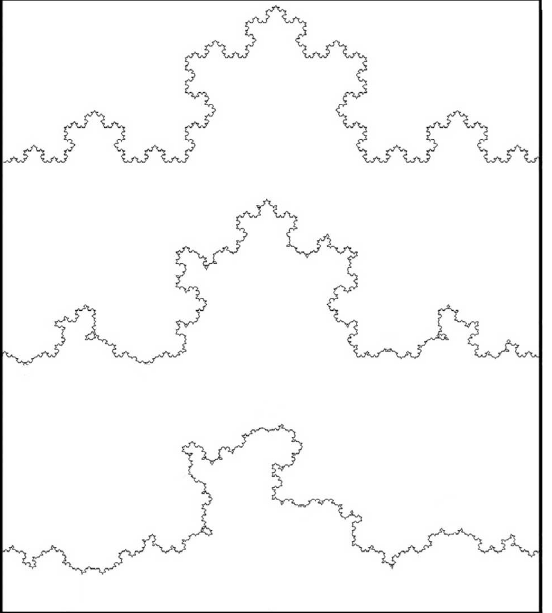
Fig 9. Koch curves quantified by D = 1.26. The exact fractal (top trace) is morphed into the statistical fractal (bottom trace). See the text for